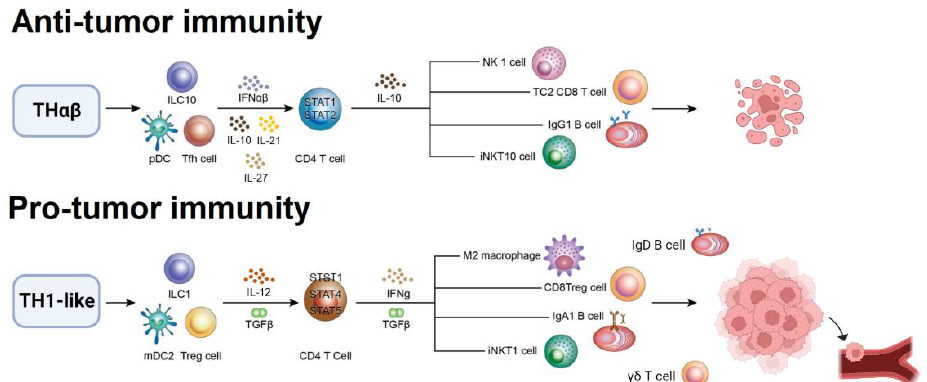
Figure 4. Anti-tumor immunity is basically TH  immunity including NK1 cells, IgG1 B cells, CD 8 T cells, and iNKT10 cells. Pro-tumor immunity is basically TH1-like immunity including M2 mac- rophages, IgA1 B cells, CD8 Treg cells, and iNKT1